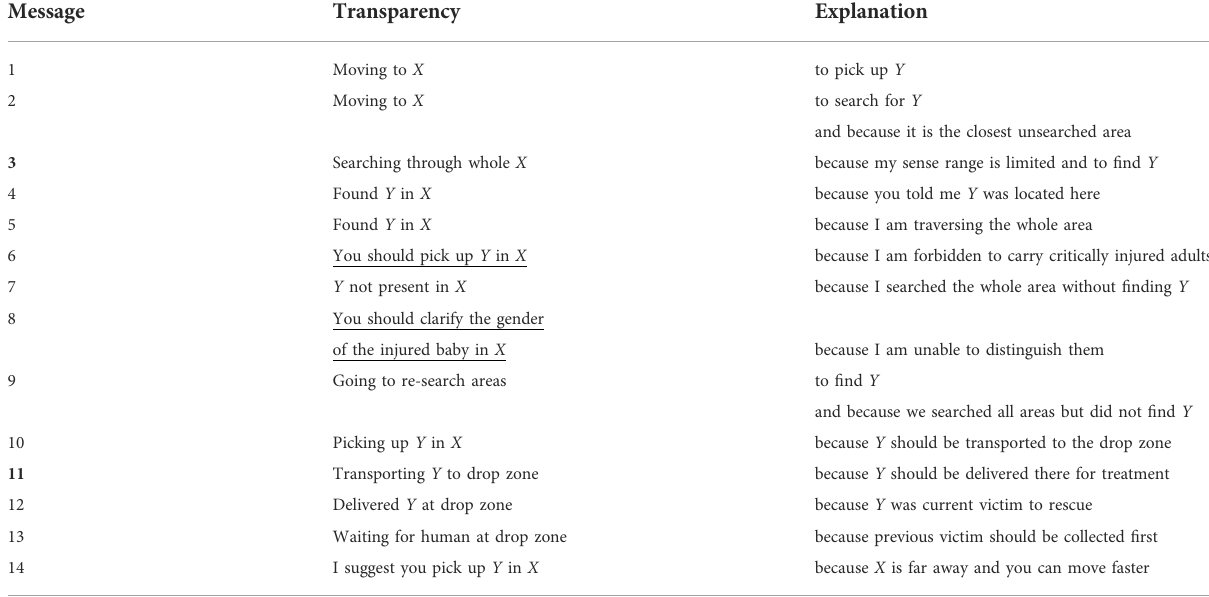
TABLE 1 The information content for each of the four communication styles. Explainability included both the content under the column Transparency, plus the explanation under the column Explanation. Underlined messages refer to the only information shared by the silent baseline. Except for the fi rst two messages, the adaptive communication style dropped the explanations after providing them once. When time pressure was high, the adaptive version of RescueBot stopped sending the messages with the bold